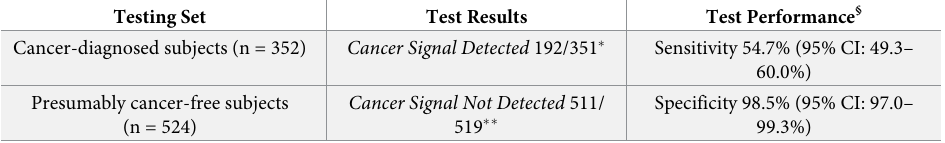
Table 5. Test results and performance in the testing set of the CANDiD study.